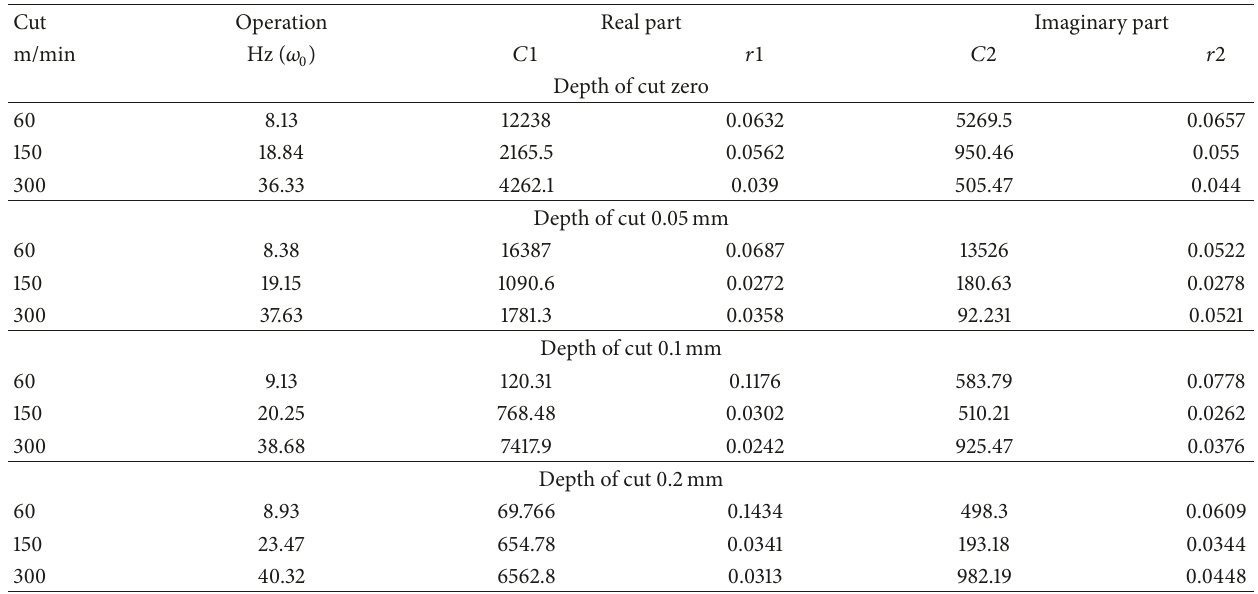
Table 3: Parameter values in relation to the operation speed, obtained with new insert.